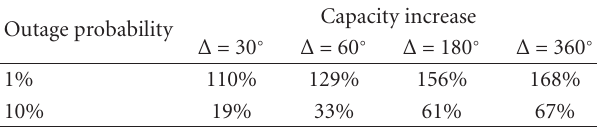
Table 2: Cellular capacity increase by using hybrid FRF ( d = λ/ 2).